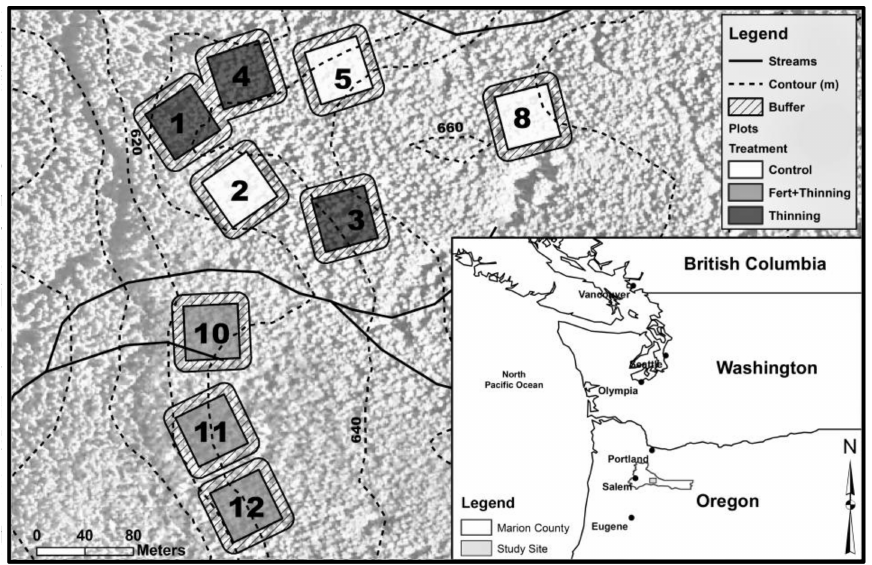
Figure 1. Location of study site (inset) and layout of treatment plots. The site coordinates are 44.87417, − 122.566 (Latitude/Longitude decimal degrees). Fert,